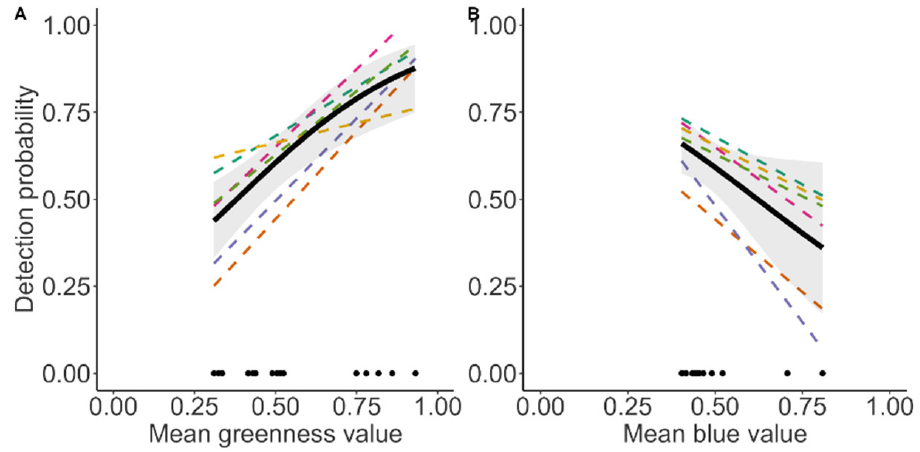
Figure 3. Probability of an observer to detect the presence of a Svalbard reindeer known to be present on a UAV image. Predicted estimates from linear mixed effect of presence/absence models (see Table A5 for the model selection). ( left ) Variation in detection probability based on the greenness index (G-B), ( right ) Variation in detection probability based on mean blue channel values. The figure shows mean detection probability with 95% confidence intervals (solid line and shaded area), individual observer differences (stippled coloured lines), and observed covariate values (black points).